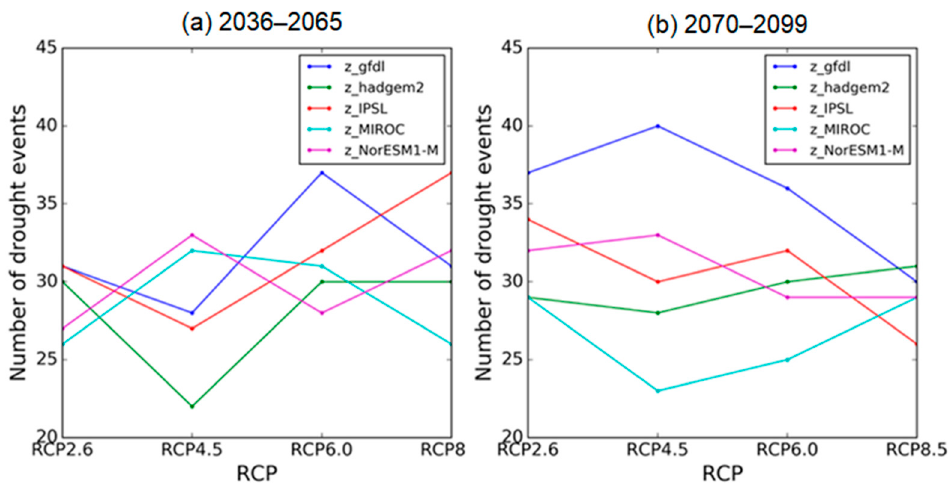
Figure 4. Expected number of drought events for the mid ( a ) and end ( b )